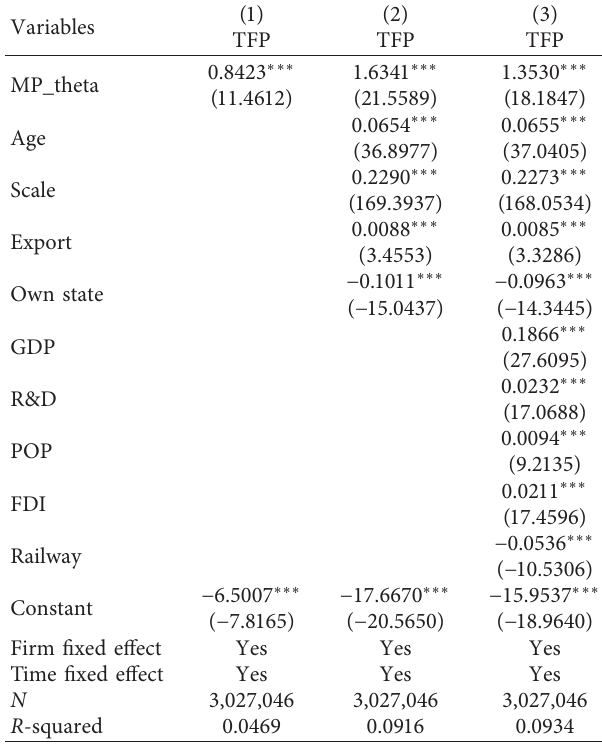
Table 11: Robust check of market potential